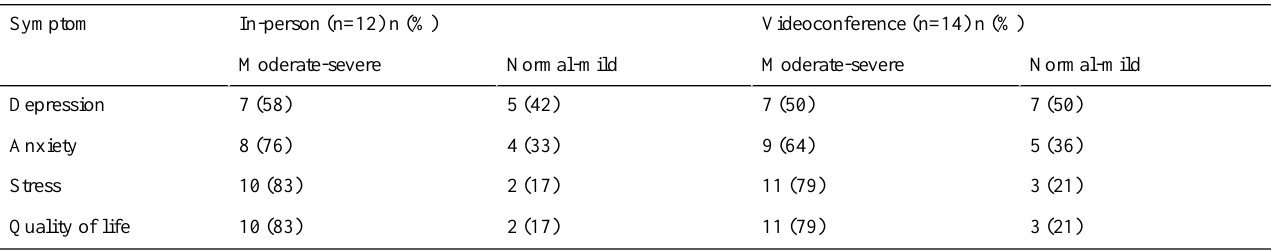
Table 8. The severity of client symptoms at